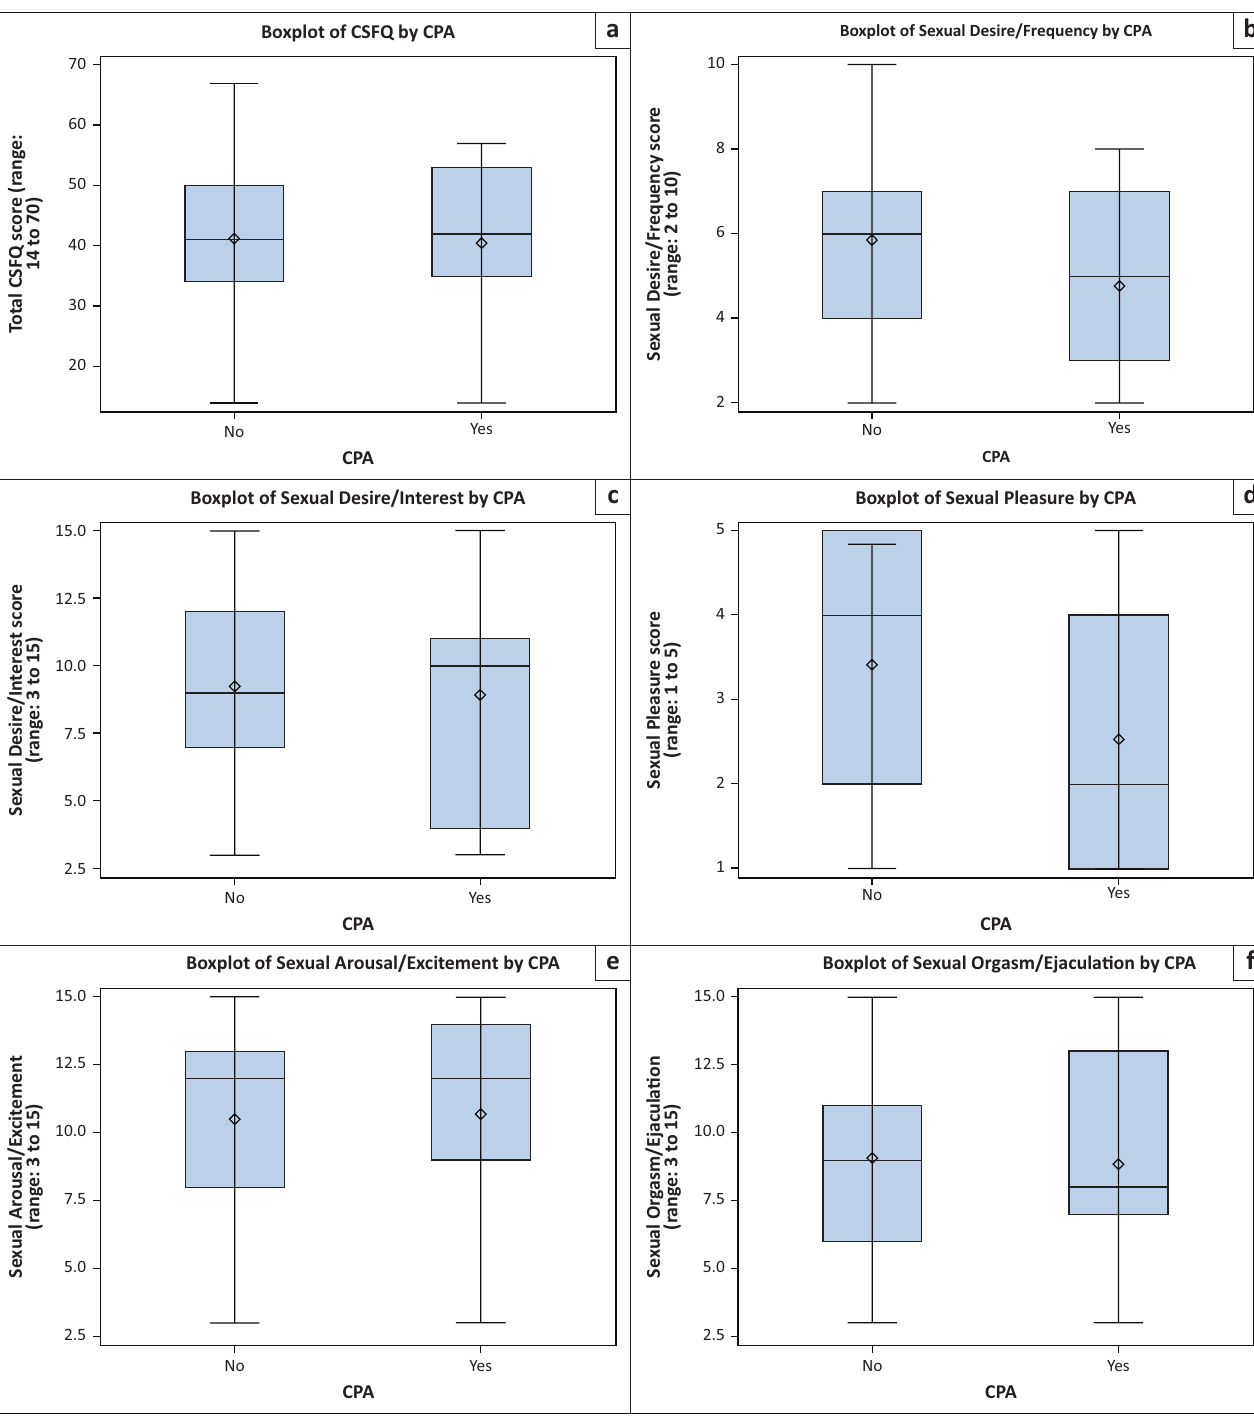
CPA, cyproterone acetate. Horizontal line in shaded box, median; Diamond in shaded box, mean. FIGURE 2: Boxplots of CSFQ-M-C total and subscale